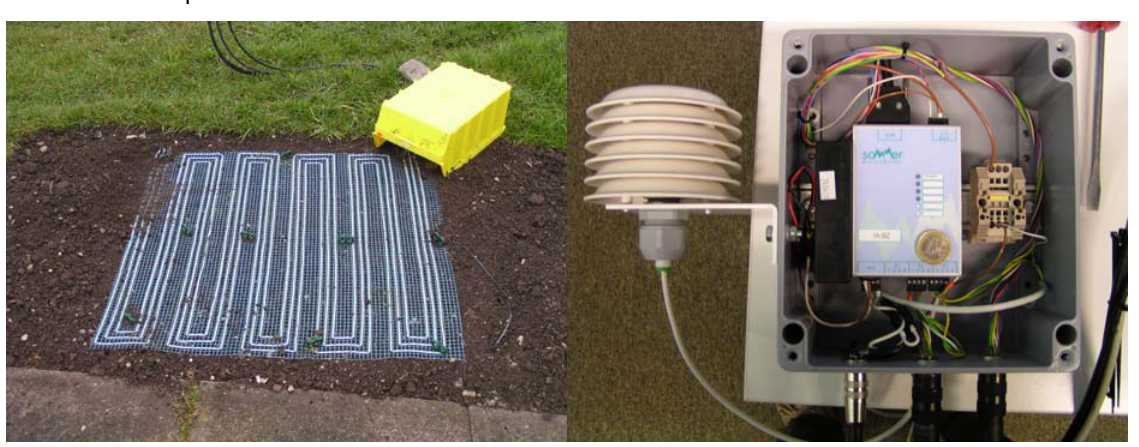
Figure 5. (left) Sensor mat for SOG detection. (right) IA in weather-proof box with an attached dew-point